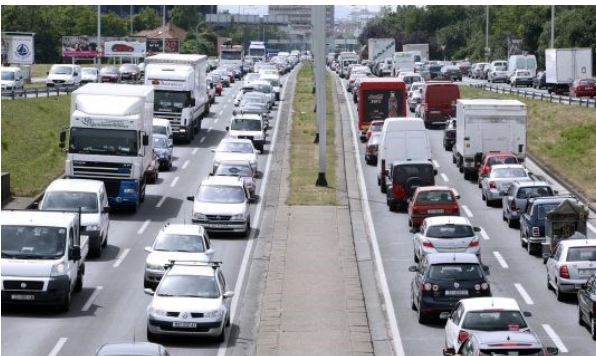
Figure 1. Big noise in Europe (A look on Slavonska avenija – main road through Zagreb), (Index.hr, 2009)